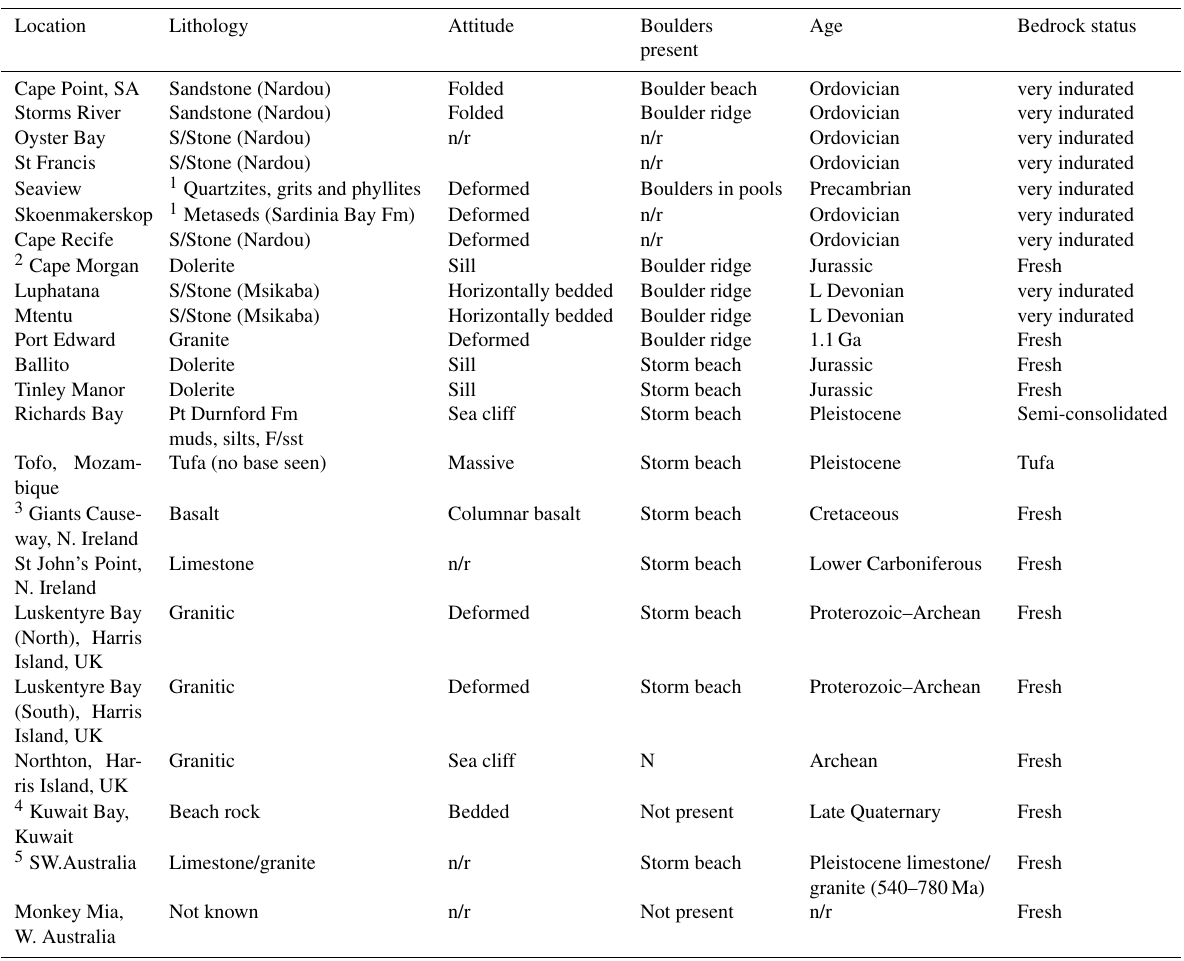
Table 2. Lithological features of shore platforms (N/R: no record).